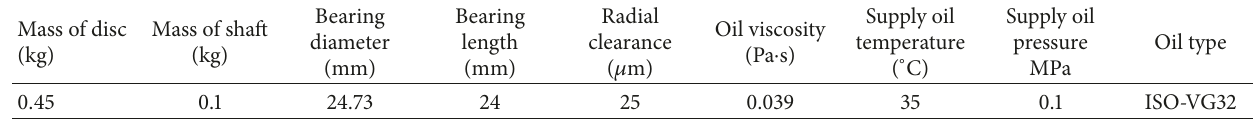
Table 1: Parameters of the rotor-bearing